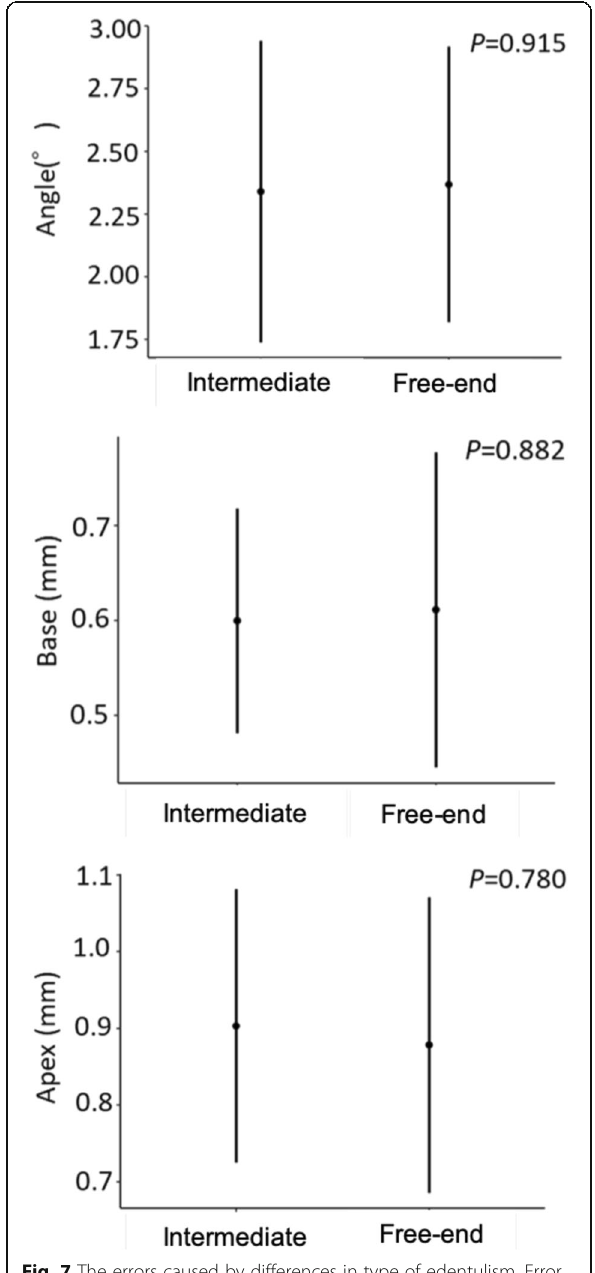
Fig. 7 The errors caused by differences in type of edentulism. Error bars indicate 95% confidence